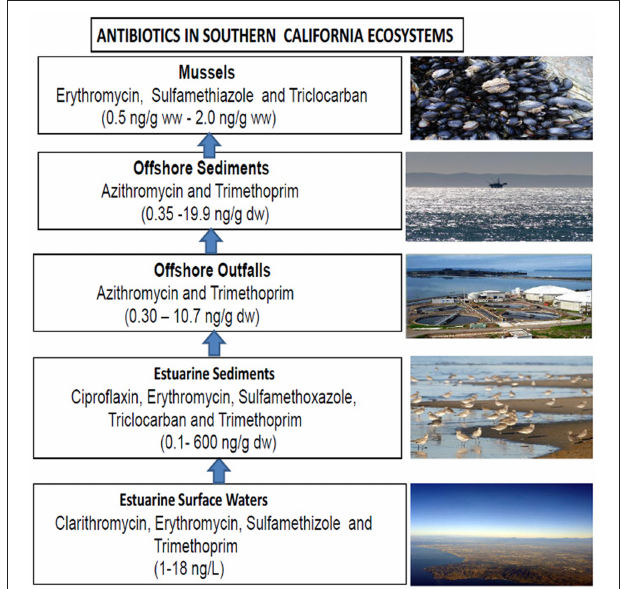
FIGURE 1 | Antibiotic concentrations measured in different environmental compartments of coastal ecosystems of southern California.